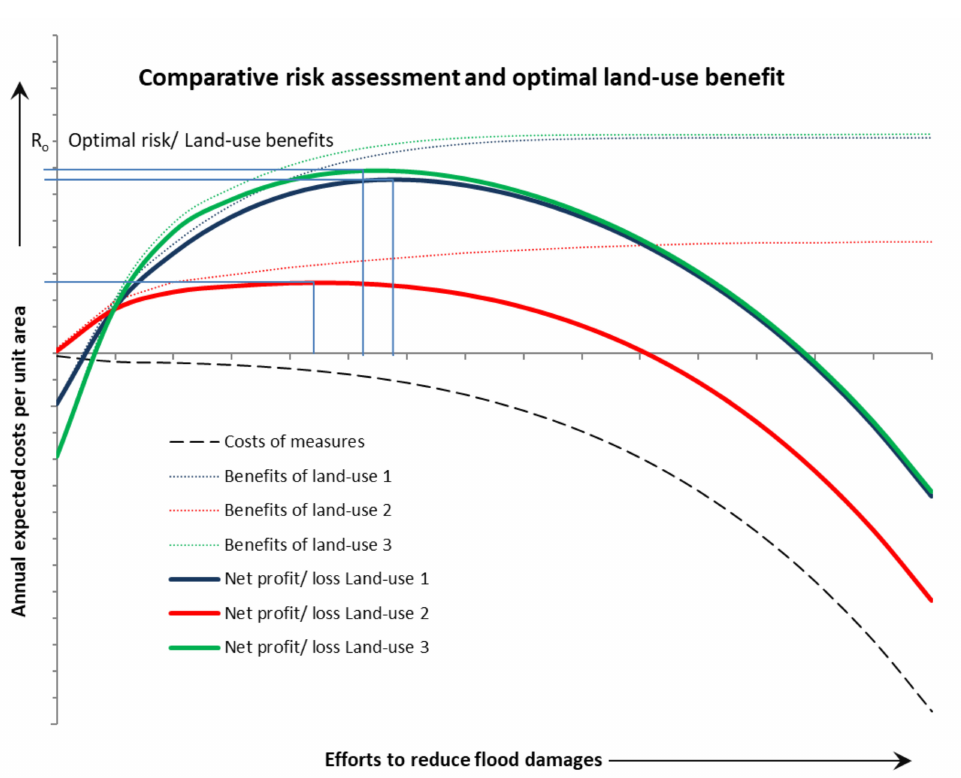
Figure 2. The graph representing the comparative risk analysis of di ff erent strategies and the identification of optimal risk for di ff erent land-use schemes in a floodplain, along with the net profit of typical land